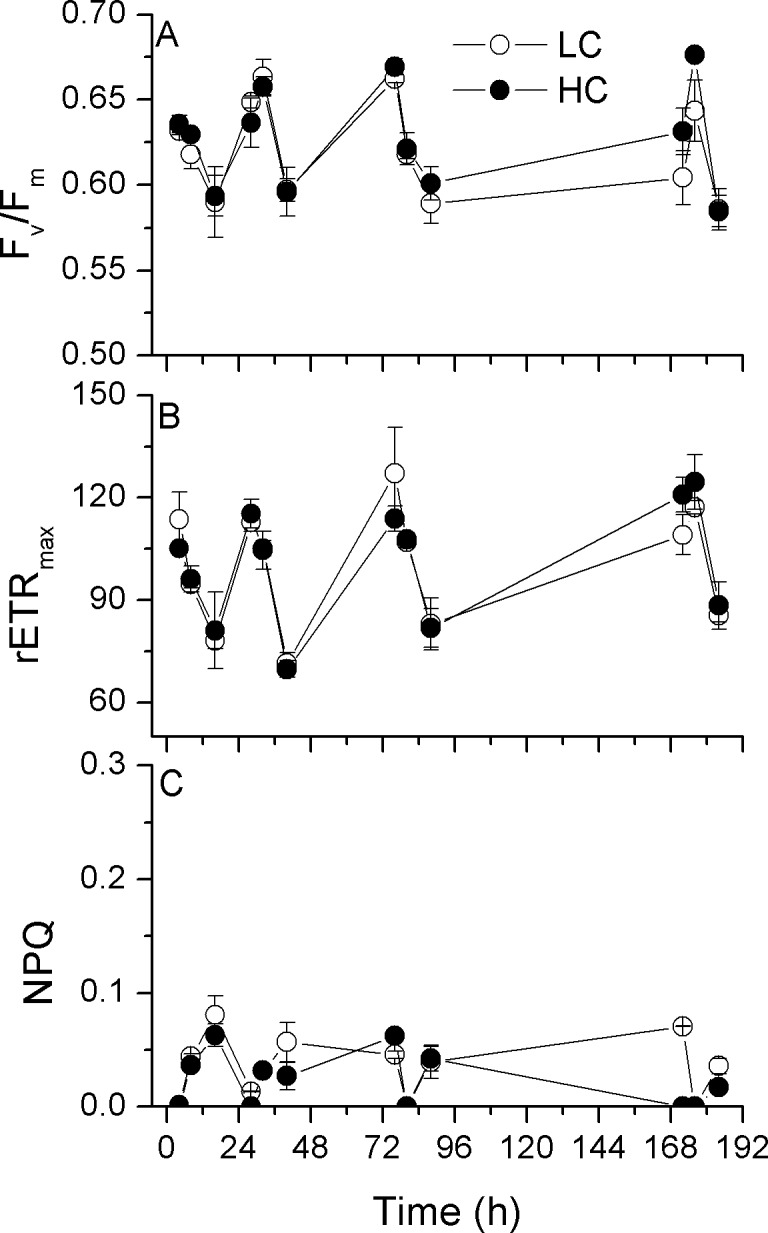
Chlorophyll fluorescence parameters of P. tricornutum.Time series of the maximal quantum yield (Fv/Fm; A), the maximal electron transport rate (rETRmax; B) and non-photochemical quenching (NPQ; C) of P. tricornutum cells grown at ambient (390 μatm; LC) and elevated CO2 (1000 μatm; HC) levels. Data are the means ± SD, n = 3 (triplicate cultures).